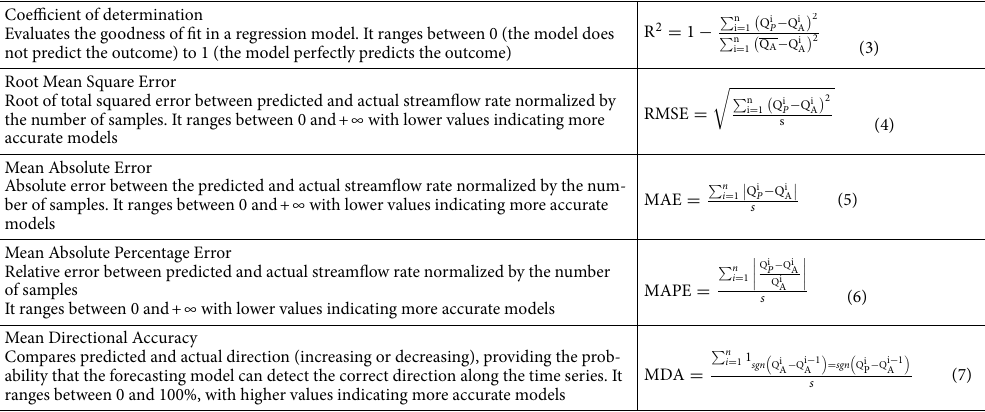
Table 2. Evaluation metrics for NARX modeling. where Q i A = measured streamflow rate for the ith data and Q i P = predicted streamflow rate for the ith data, Q A = mean streamflow rate, n = number of samples, sgn(·) = sign function, 1 = indicator